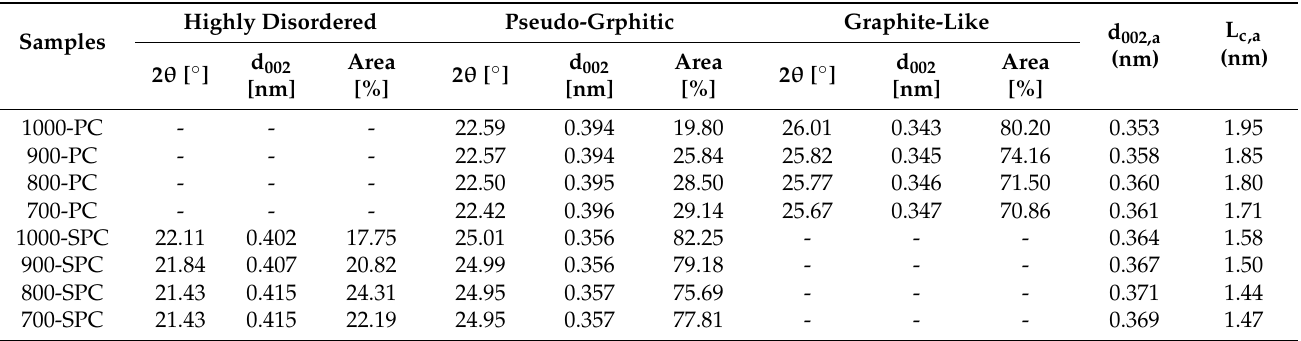
Table 1. Physical Parameters of Different